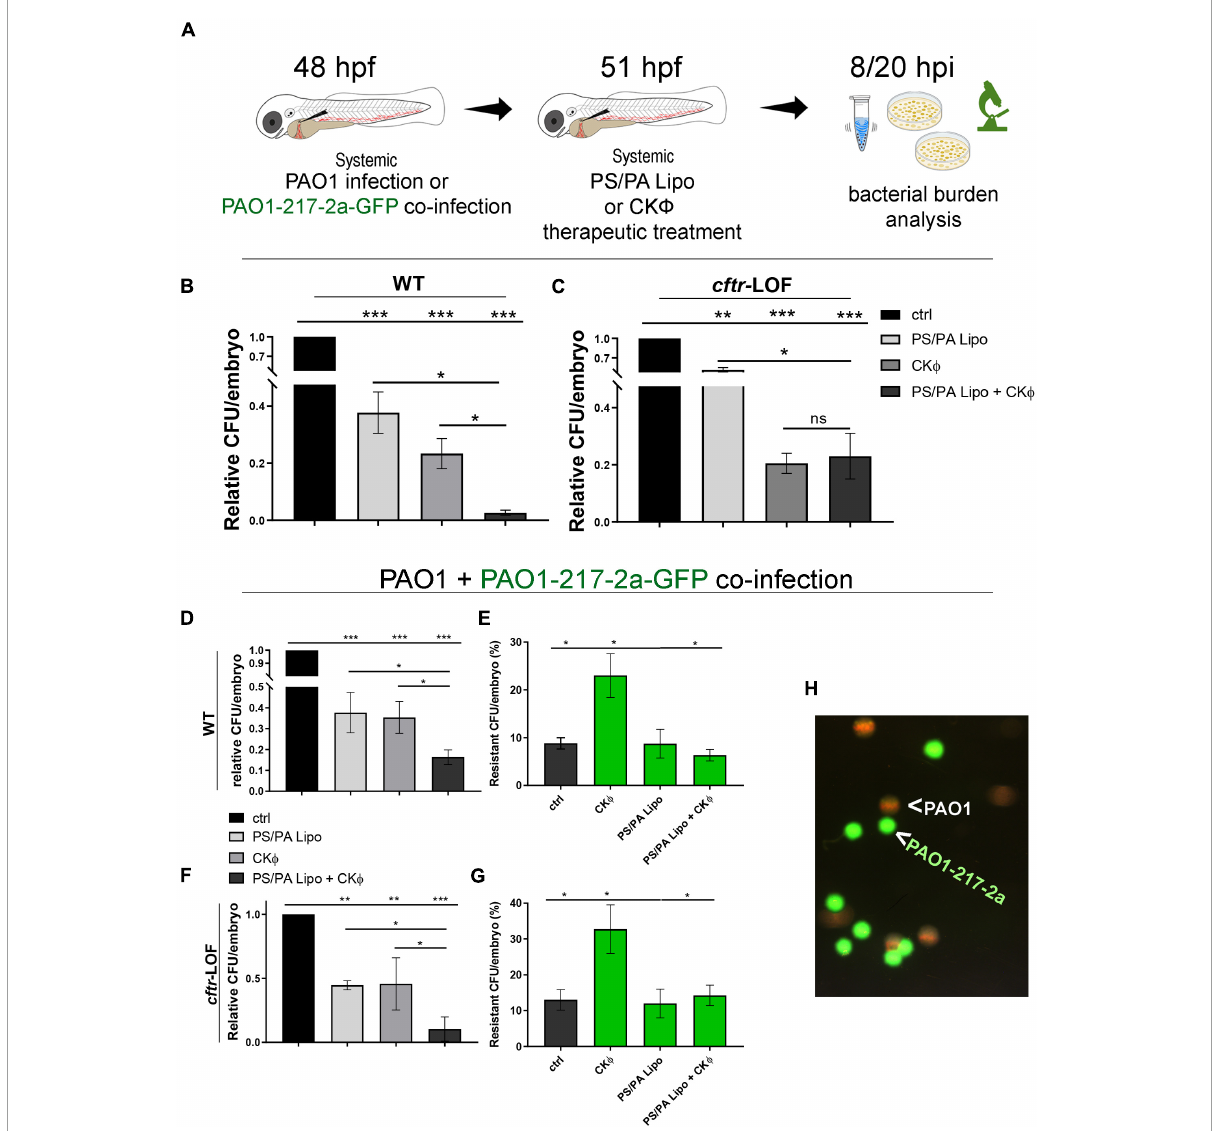
FIGURE4 Combination treatment with phosphatidylserine/phosphatidic acid (PS/PA) liposome and CK (cid:56) in therapeutic administration elicits synergistic effect in antimicrobial activity in wild-type (WT) and decreases phage-resistant PAO1 proliferation in cftr -LOF zebrafish embryos. (A) Schematic representation of combined administration of PS/PA liposome/CK (cid:56) . 48 hpf zebrafish embryos were systemically infected with phage sensitive (PAO1) and/or resistant PAO1 (PAO1-217-2a-GFP) strains, treated with single or combined PS/PA liposome CK (cid:56) 3 h later and analyzed for bacterial burden at 8 or 20 h post infection. (B,C) Bacterial load (relative CFU/embryo) in systemically infected WT (B) and cftr -LOF embryos (C) , control (ctrl), PS/PA liposome, CK (cid:56) and PS/PA liposome-CK (cid:56) treated at 8 hpi. (D–G) Bacterial load (relative CFU/embryo) (D,F) and percentage of PAO1-217-2a-GFP colonies (E,G) in embryos systemically infected with 50% phage-sensitive PAO1 (non-GFP) and 50% phage-resistant PAO1-GFP bacterial suspension. WT (D,E) or in cftr -LOF embryos (F,G) , control (ctrl), PS/PA liposome, CK (cid:56) and PS/PA liposome-CK (cid:56) treated. (H) Representative image of phage-sensitive PAO1 and phage resistant PAO1-217-2a-GFP colonies derived from the plating of homogenized infected embryos. Statistical significance was assessed by One-way ANOVA test followed by Tukey’s post hoc correction:*** p < 0.001; ** p < 0.01; * p < 0.05; ns, not significant. Data resulted from three independent experiments and results are presented as mean ±